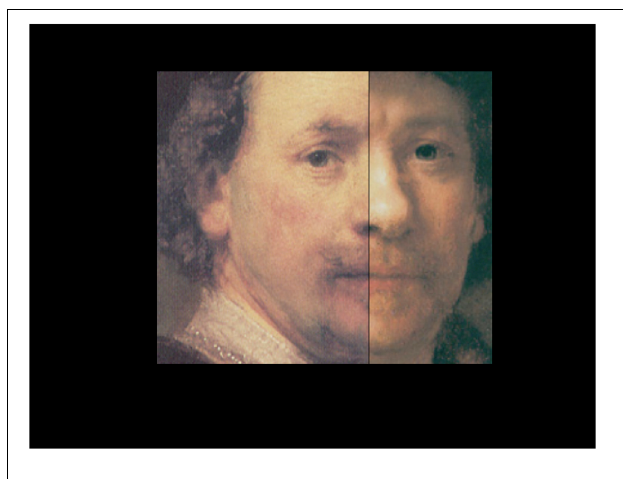
FIGURE 1 | A chimera image of a portions of a pair of Rembrandt self-portraits: one half image is from a genuine self-portrait by Rembrandt (Norton Simon Museum of Fine Art, Pasadena); the other half image is from a portrait attributed to Rembrandt (Museo Thyssen-Bornemisza, Madrid), whose authenticity has been hotly debated among experts for more than 40 years, see pp. 361–370 in (van de Wetering, 2005). Chimera image prepared by Martin